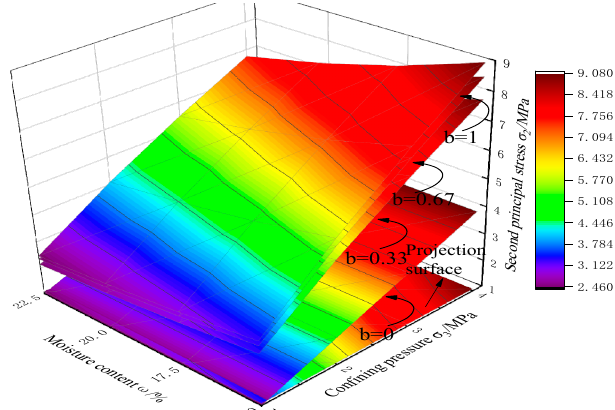
Figure 5. Three-dimensional trend chart of water content, confining pressure, and high principal stress under different b values [23].